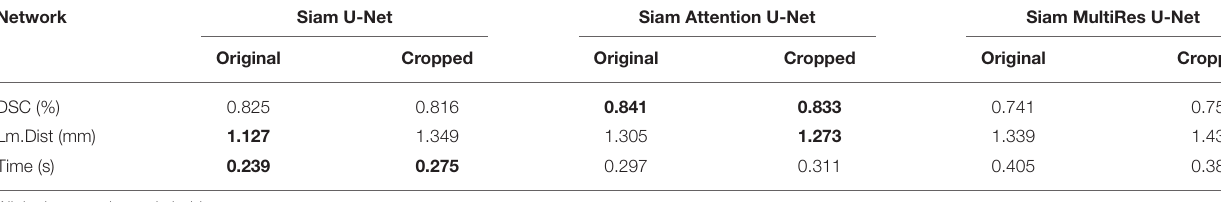
TABLE 1 | Registration performance of cross-size carotid artery input. Network